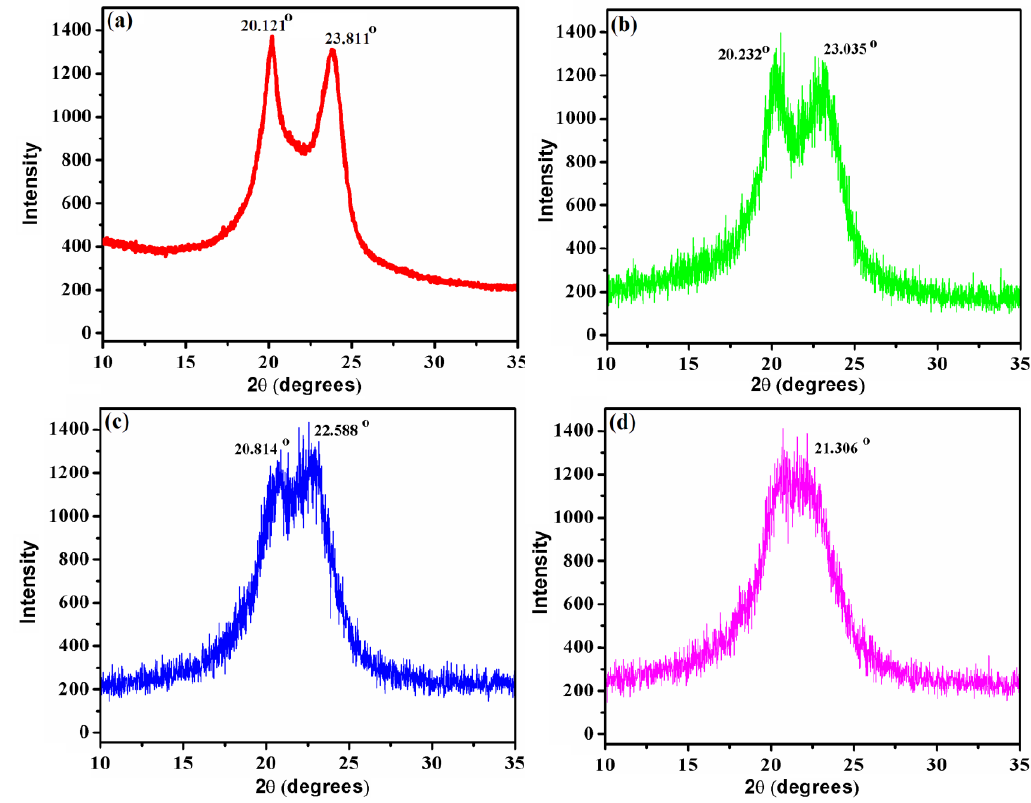
Figure 3. X-ray diffraction pattern of ( a ) virgin PA6, ( b ) PA6-BABA/SA 30 , ( c ) PA6-BABA/SA 50 , and ( d ) PA6-BABA/SA 70 .